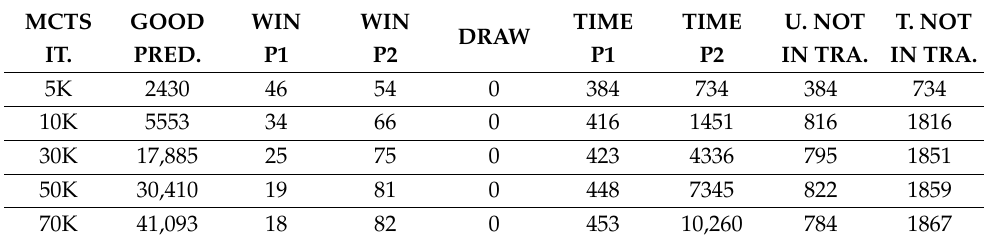
Table 5. Results from starting node State S with